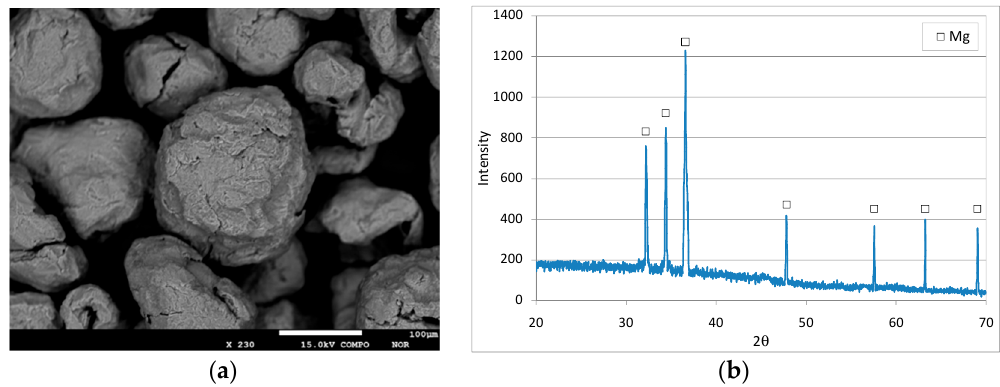
Figure 1. SEM image ( a ) and XRD diffractogram ( b ) of Mg 0 particles.